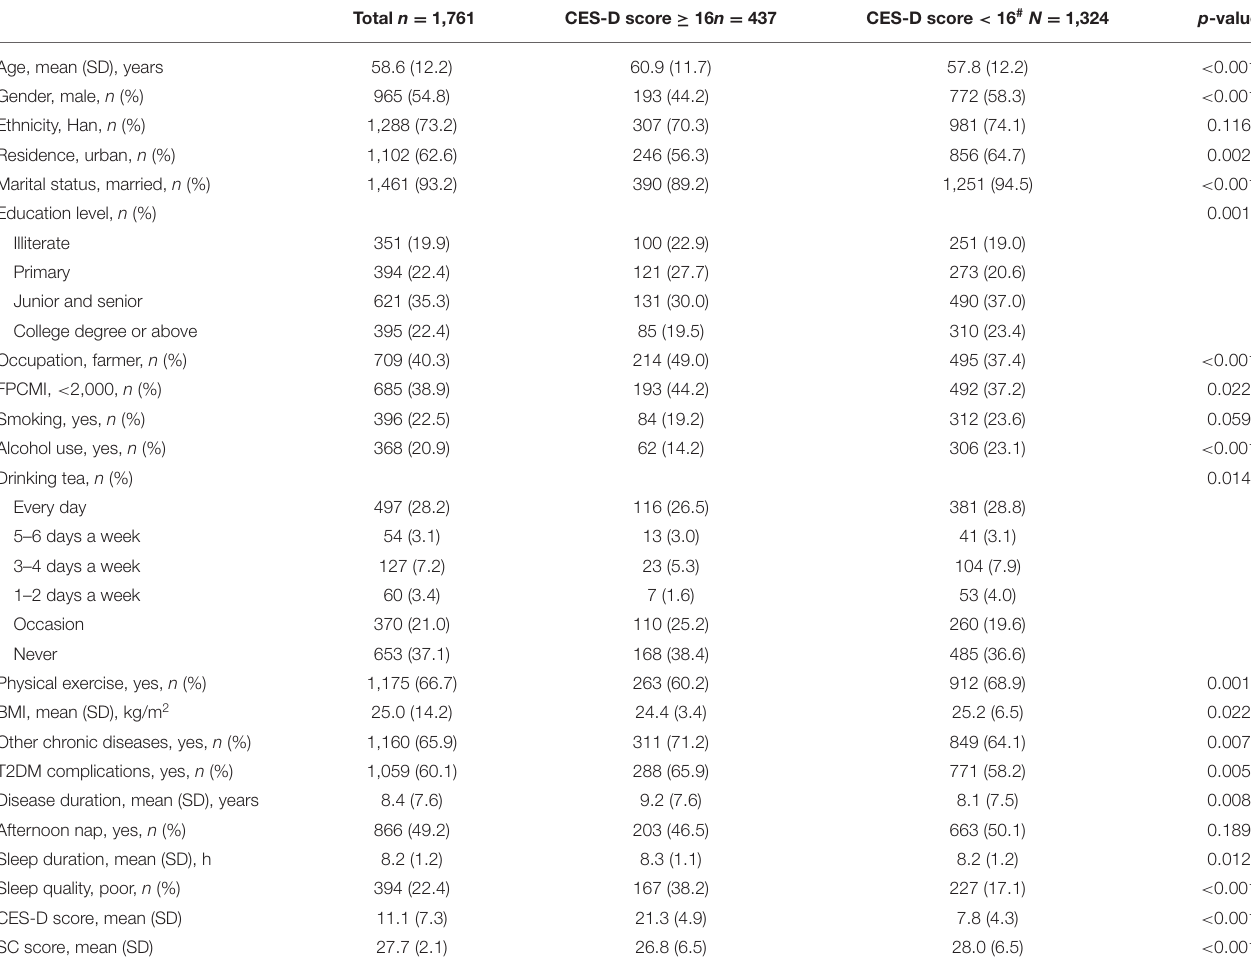
TABLE 1 | Demographic characteristics of the participant.